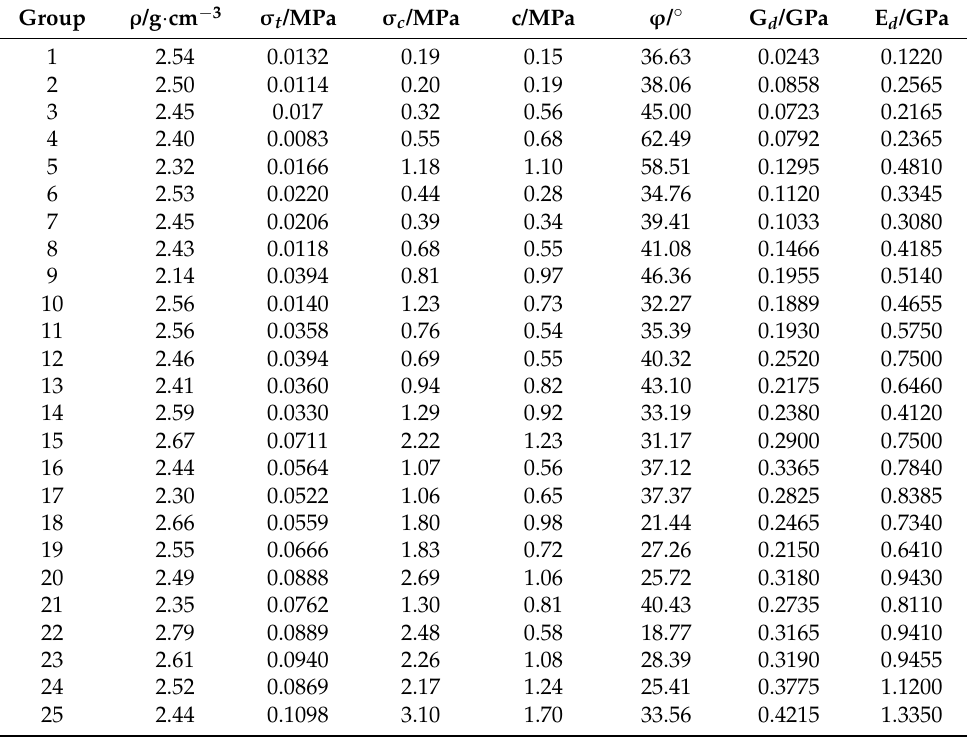
Table 3. Orthogonal test results for model materials similar to